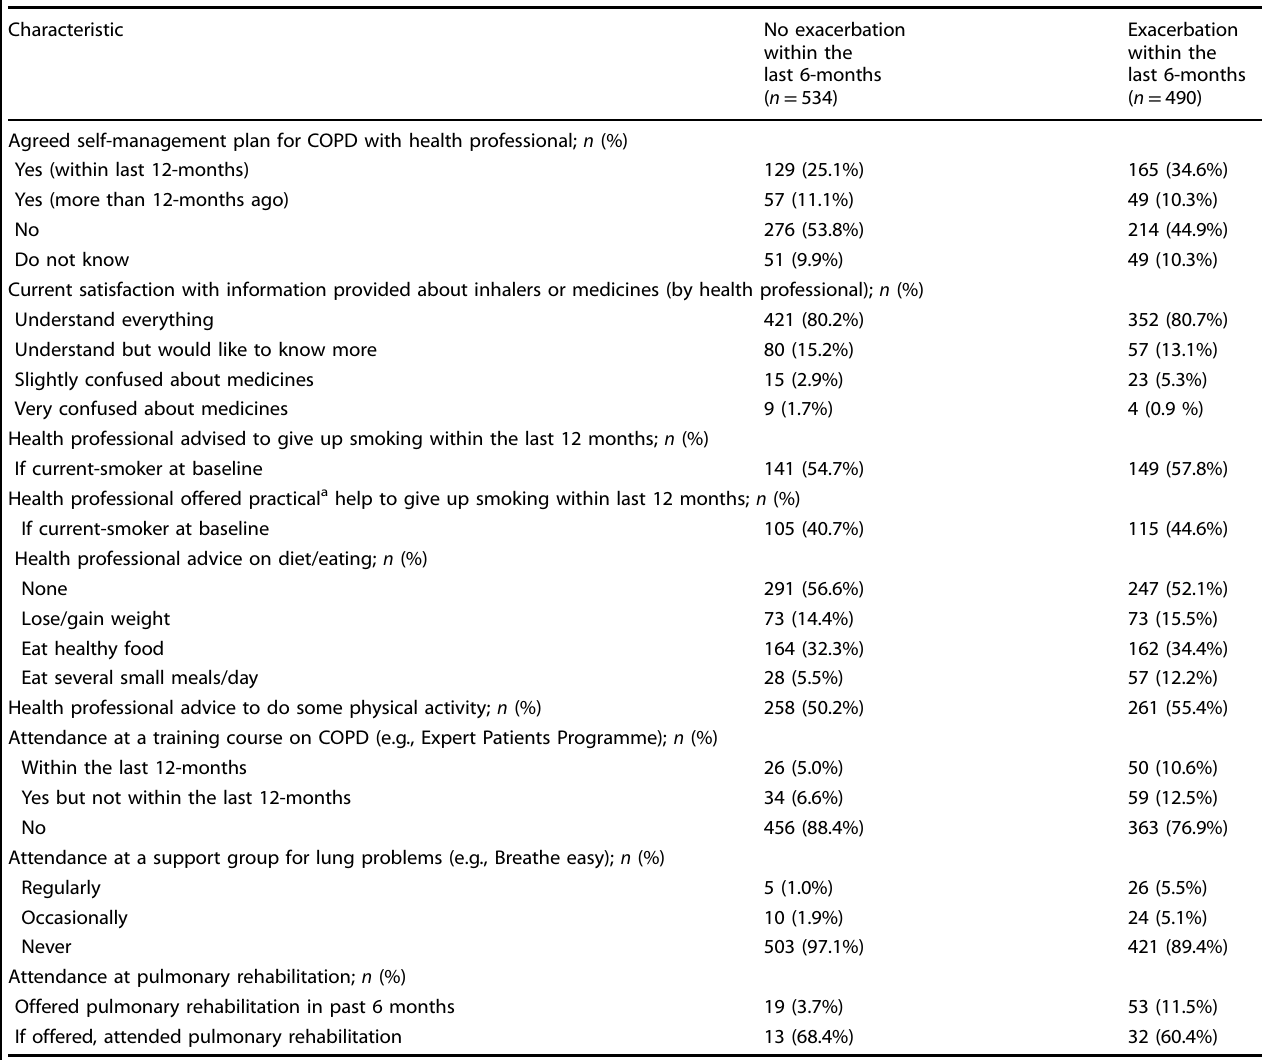
Table 5. Self-management support: Plans and healthcare professional advice